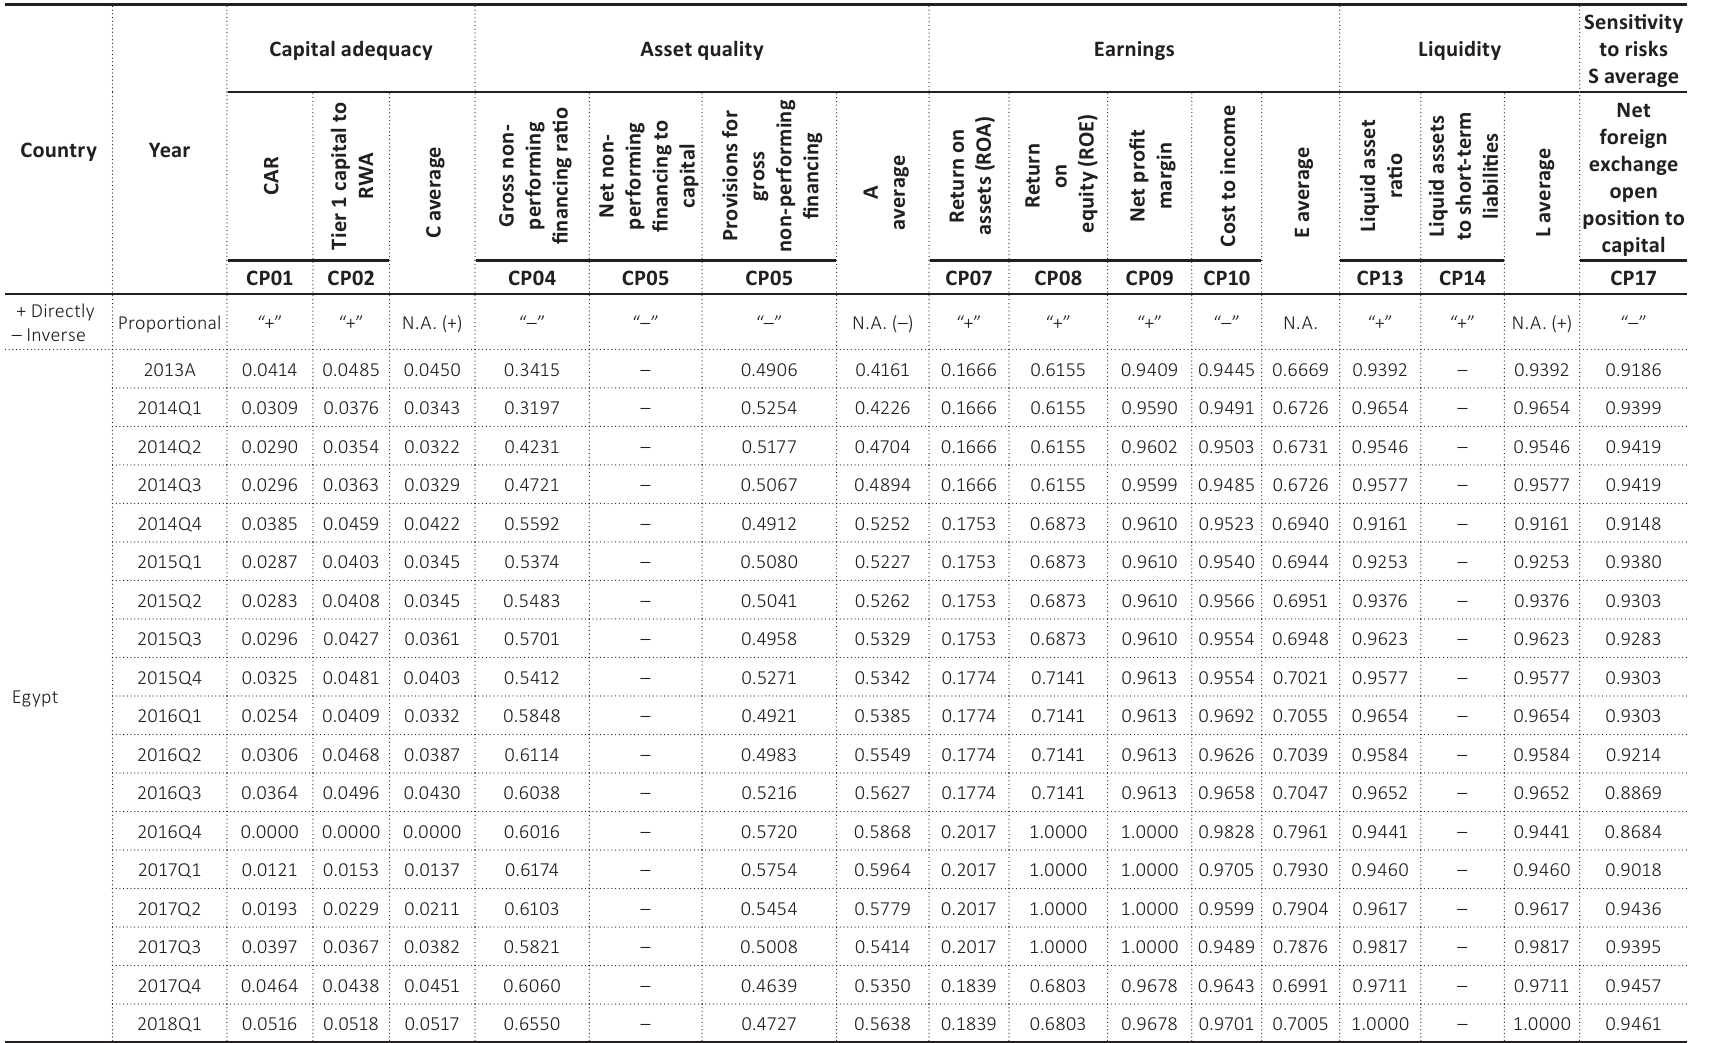
Source: Own calculation based on IFSB